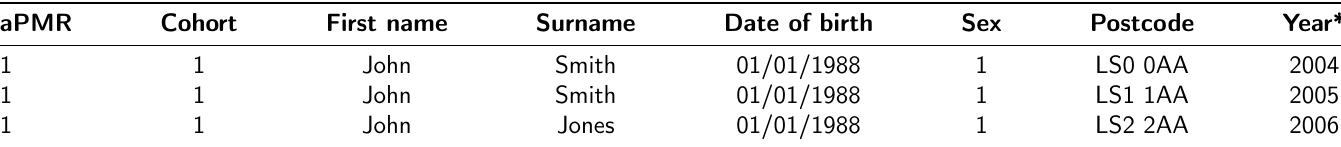
Supplementary Table 2: Example of NPD linkage table